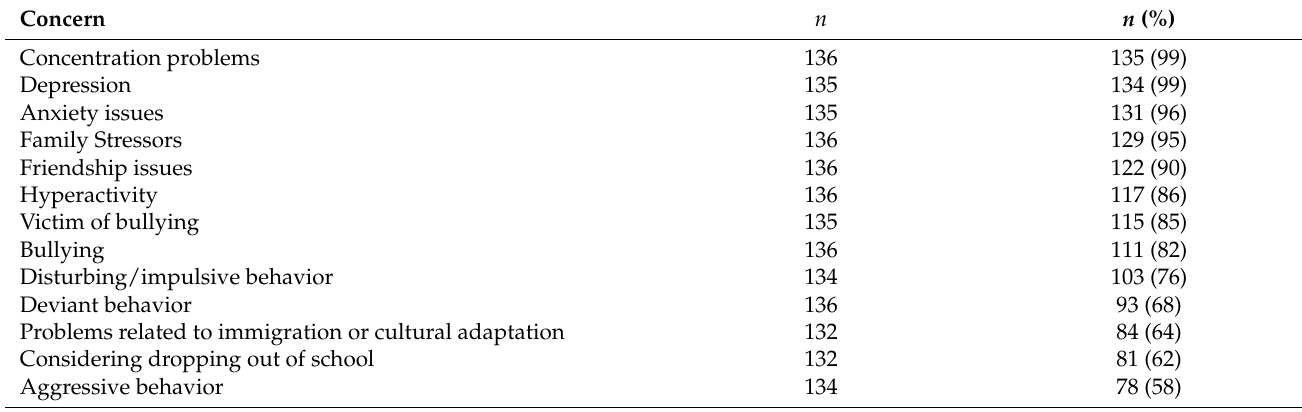
Table 2. Reported student mental health concerns within past year and mental health services and interventions used in